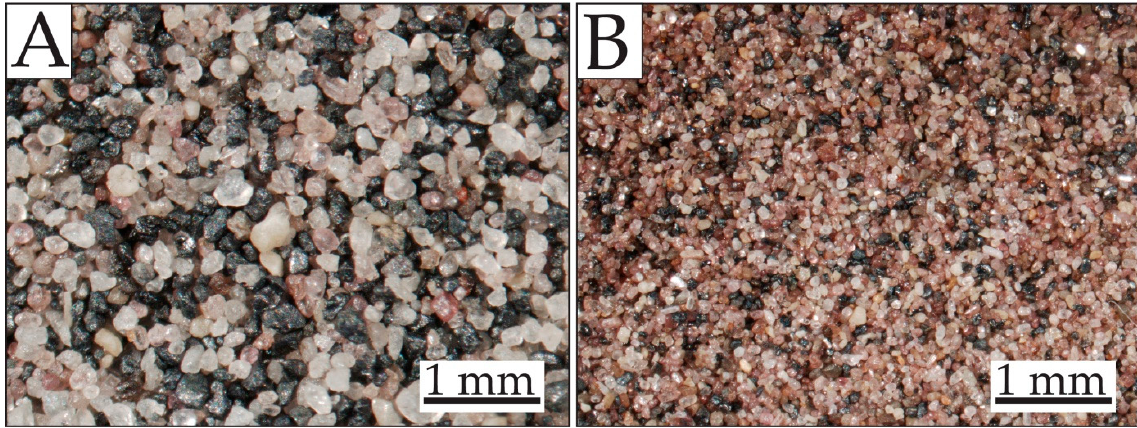
Figure 3. Tailing after the post-processing of cassiterite-bearing sands: ( A ) tailing from Nyelanding, sample Bngk 4; ( B ) tailing from Pemali–Bngk 16. Stereoscopic image magn. ×2.